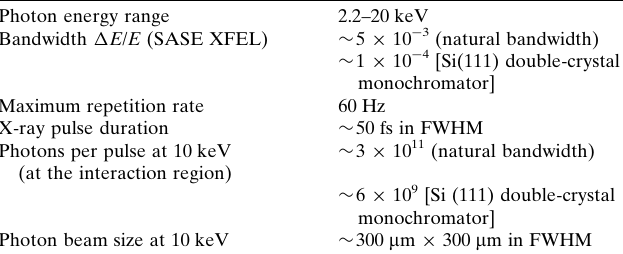
Table 1 Summary of the key parameters of the photon beam. Photon energy range